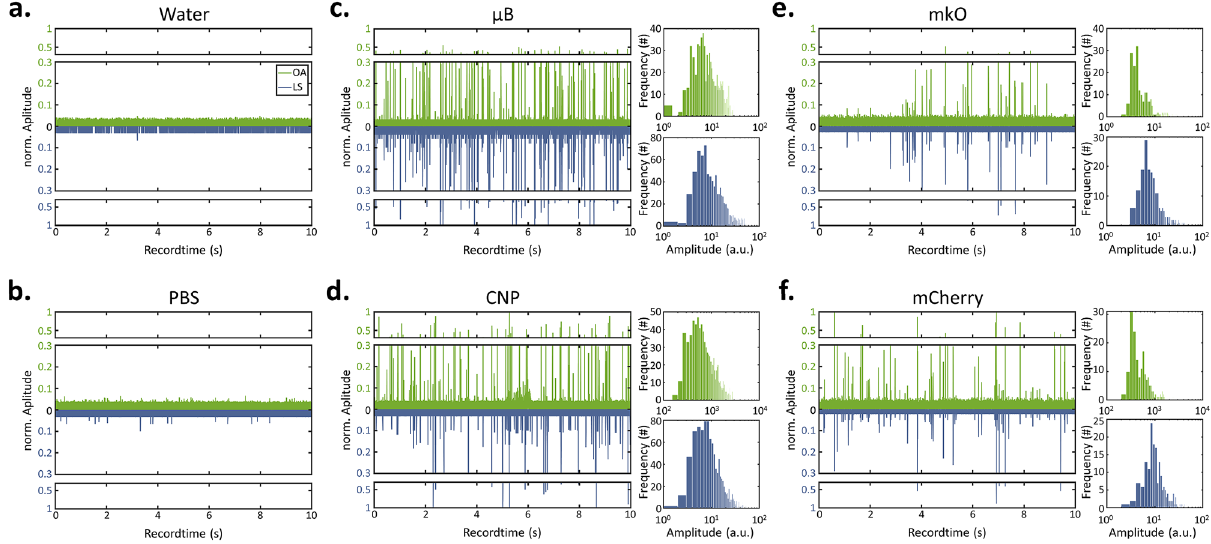
Figure 2. Characterization of in-flow signals at 100 μL/min. Normalized OA and LS trajectories of ( a ) water as the solvent for μB and CNPs as well as of ( b ) PBS as the buffer for the cell suspension exhibit no detected transit event over 10 s record time. Water-suspended ( c ) μB and ( d ) reveal OA and LS signals of transits of individual particles. Unnormalized histograms are shown Gaussian-shaped distribution over the entire 1 min measurement. Normalized OA-FCM trajectories of E. coli expressing ( e ) mKO or ( f ) mCherry in PBS reveal detectable in-flow signals following a Gaussian-shaped distribution in the associated